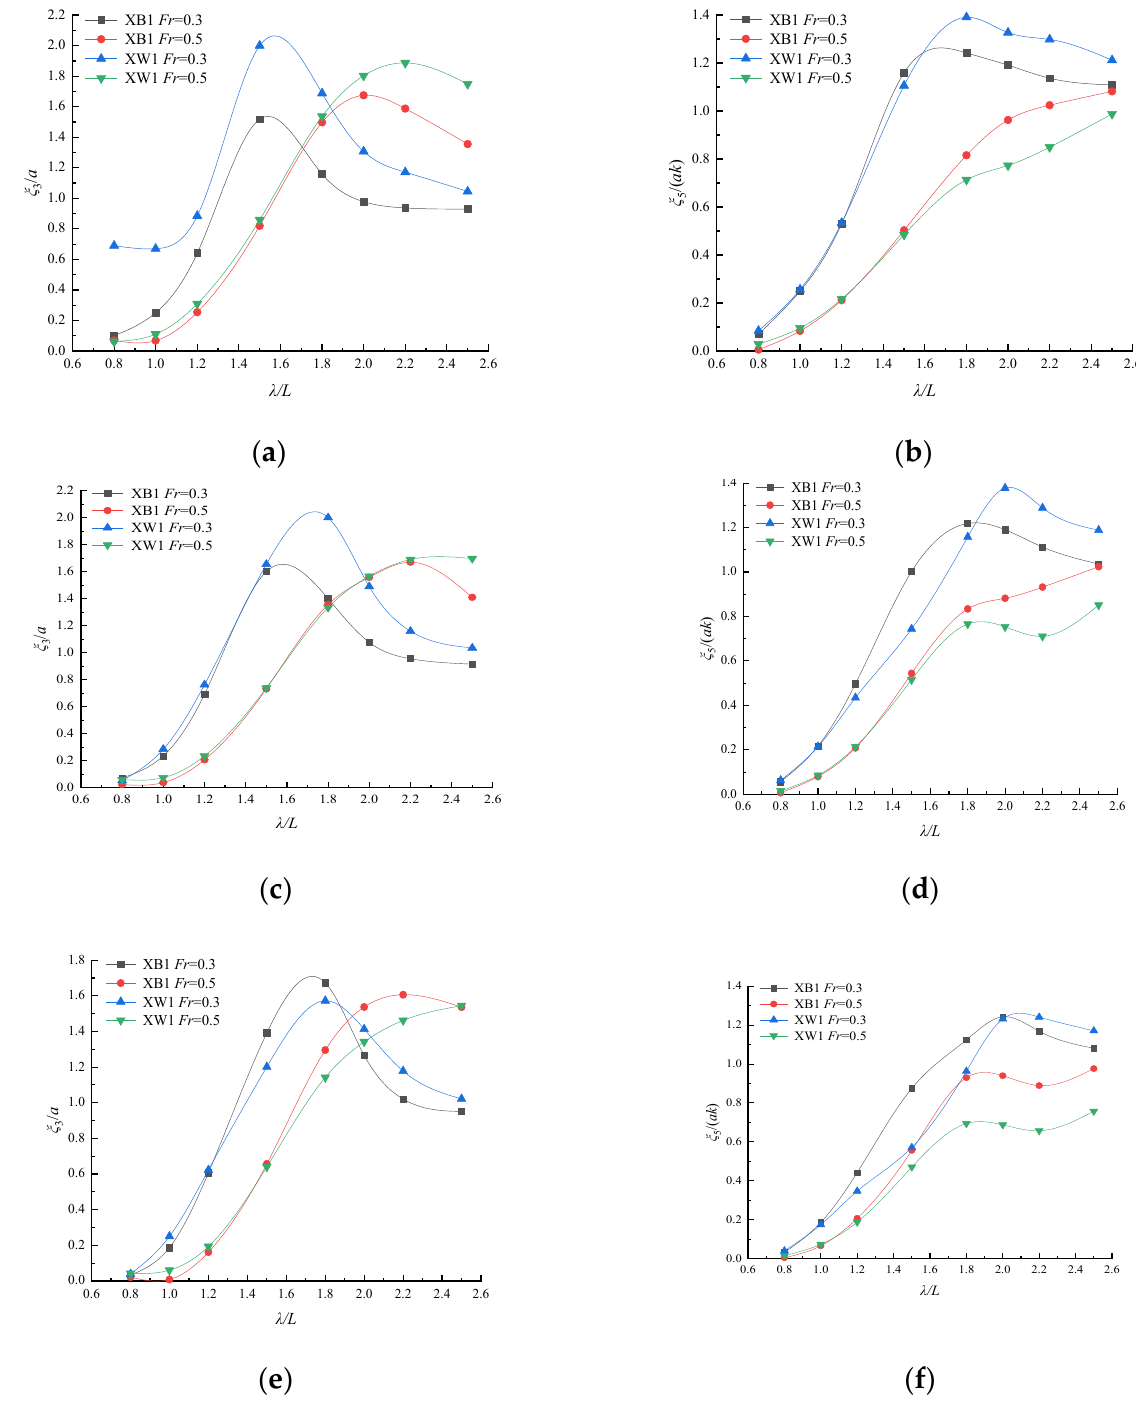
Figure 8. Heave and pitch responses of XB1 and XW1 subjected to different wave conditions; ( a ) Heave, H = 0.04 m ( b ) Pitch, H = 0.04 m ( c ) Heave, H = 0.08 m ( d ) Pitch, H = 0.08 m ( e ) Heave, H = 0.12 m ( f ) Pitch, H = 0.12 m.